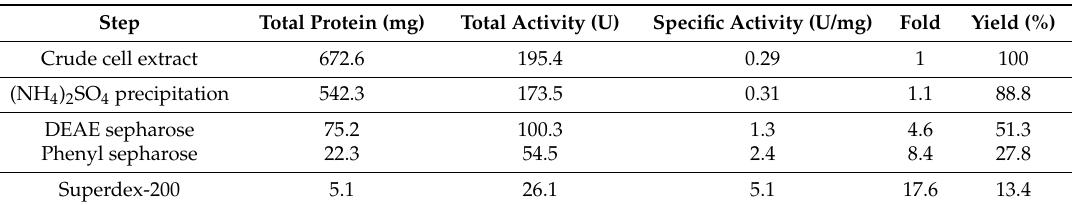
Table 1. Purification of a novel HSP (6 ‐ hydroxy ‐ 3 ‐ succinoylpyridine) hydroxylase from Pseudomonas sp. ZZ ‐ 5 (HSPH ZZ ).